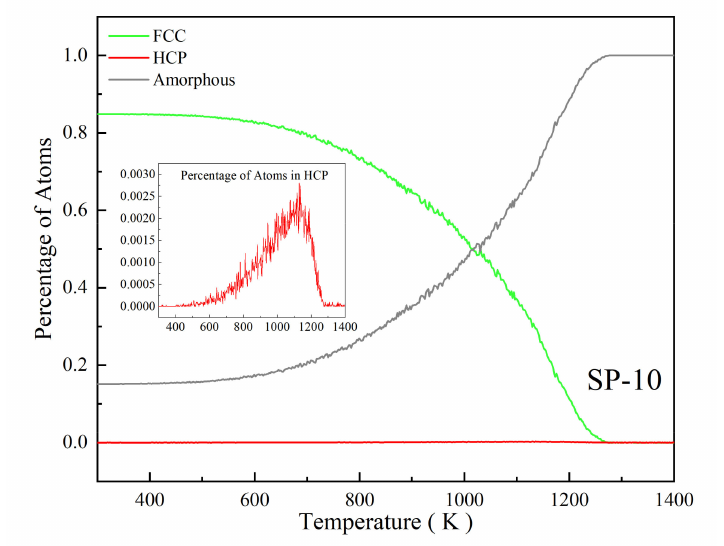
Figure 4. Percentage of atoms in different local structures corresponding to